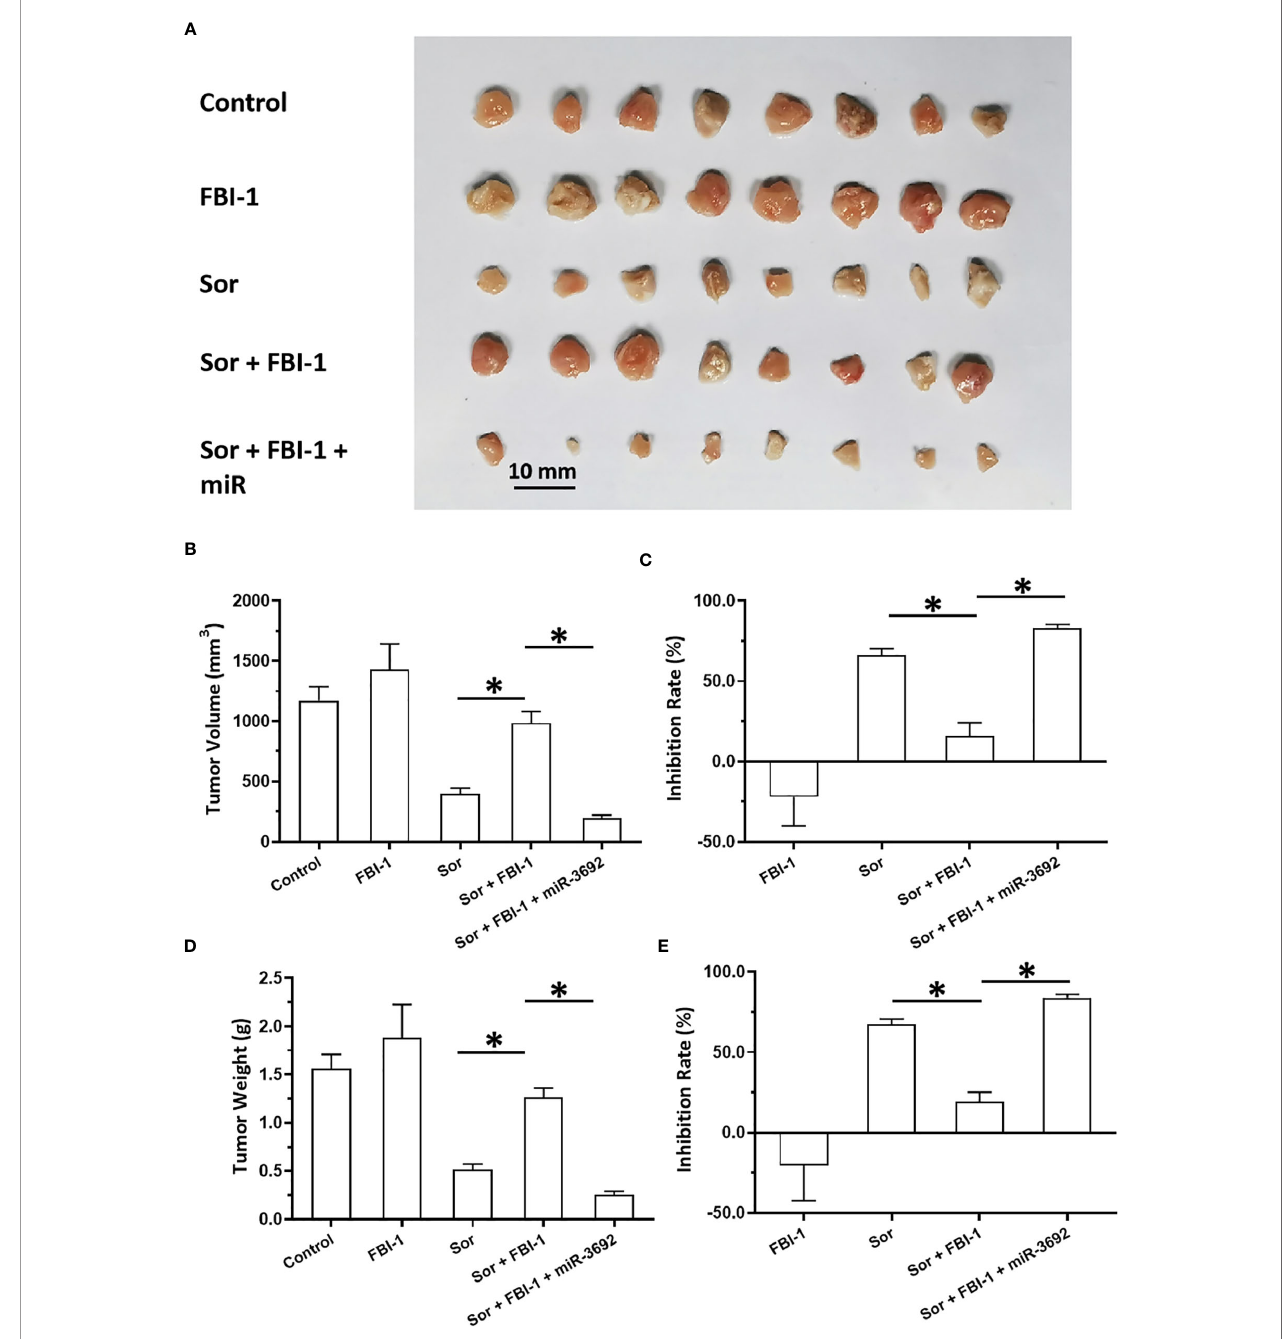
FIGURE 6 | FBI-1 enhanced the resistance of MHCC97-L cells to Sorafenib in a nude mice model. The MHCC97-L cells were transfected with vectors and injected into the nude mice to form the subcutaneous tumor models. The mice received the oral administration of 3 mg/kg Sorafenib. The results are shown as images (A) or quantitative results (B – E) . *p <